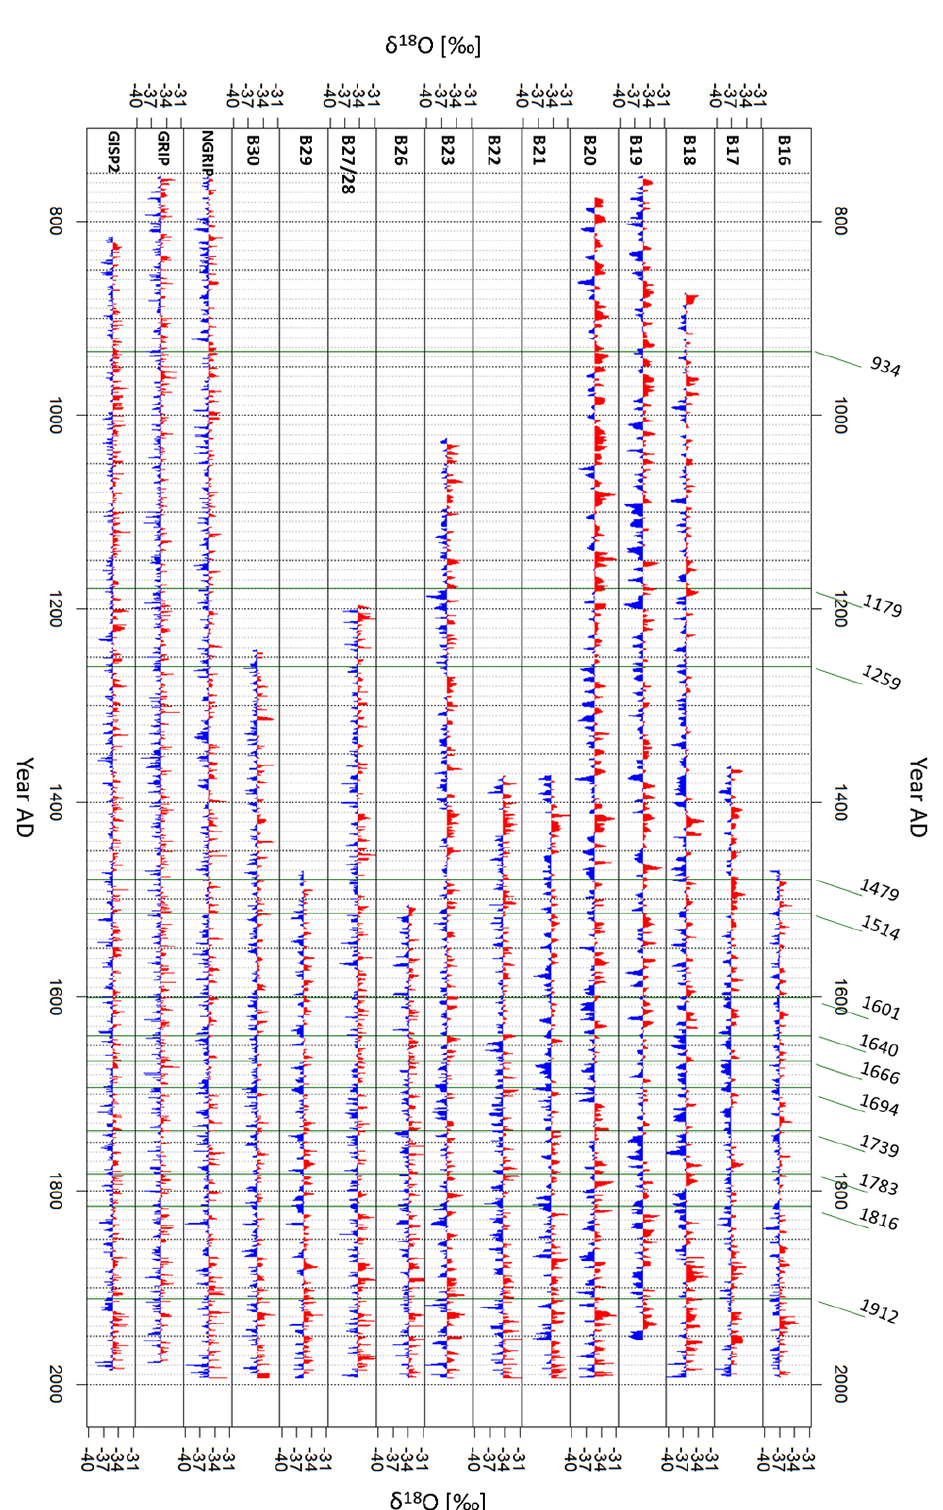
Figure 2. Annual δ 18 O records at the 12 NGT sites (this study) and NGRIP (Vinther et al., 2006b), GRIP (Vinther et al., 2010) and GISP2 (Grootes and Stuiver, 1997). Blue values are those below the mean over their common time frame (AD1505–1953) and red are the higher ones. Dark-green vertical lines mark the volcanic eruptions (years given at top) used as time